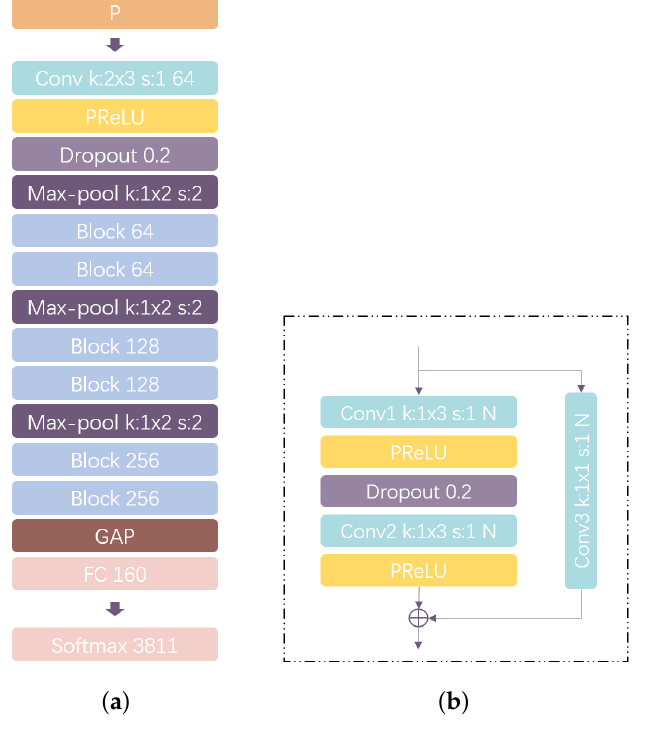
Figure 5. ( a ) The configuration of end-to-end convolutional neural network. ( b ) The architecture of residual convolution